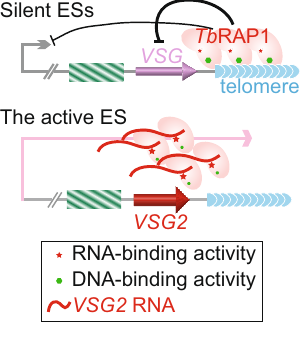
Fig.8|Atentativemodelforthefunctionof Tb RAP1RRM- VSG RNAinteraction. Dark lines with terminal bars represent repressive effect. Thicker line represents stronger effect. Red curved lines represent nascent VSG2 RNA. Red star and green hexagon represent the RNA and dsDNA binding activities of Tb RAP1, respectively. Binding VSG2 RNA competes Tb RAP1 ’ s ability to bind local telomeric